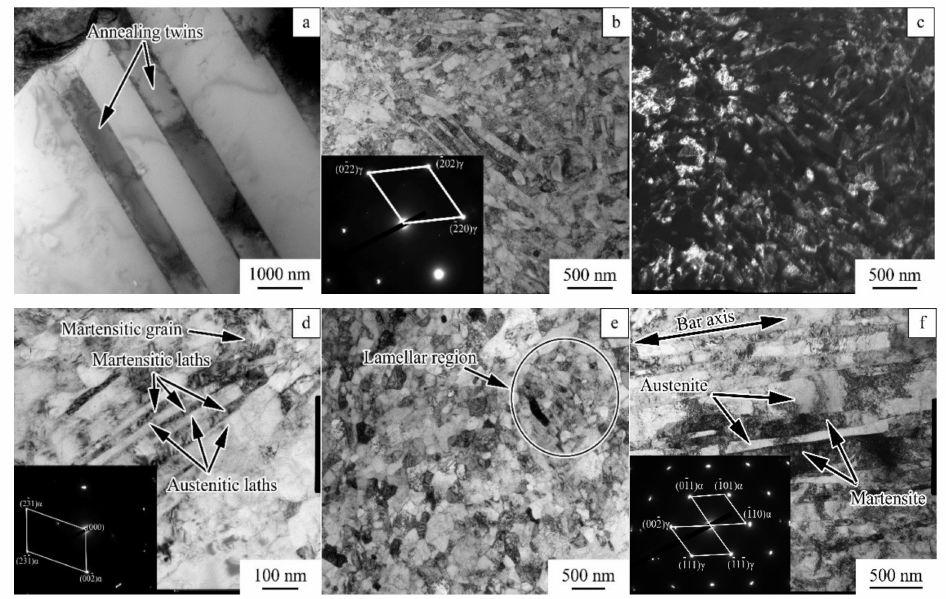
Figure 2. TEM micrographs of the program steel in the ( a – e ) transversal and ( f ) longitudinal sections the ( a ) as-received and ( b – f ) as-processed state: ( a , b , d – f )—bright-field images; ( c )—dark-field images from ( b ) at the ( 202 ) γ reflection.